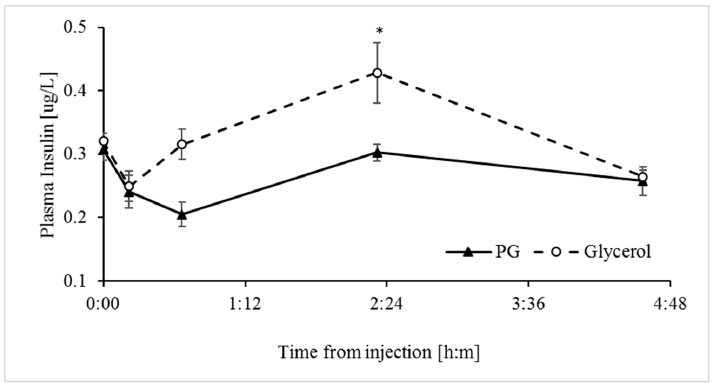
Figure 4. Insulin response to the propylene glycol and glycerol treatments. Analyses indicate the effects of Treatment and Time (Table 1). * Significant difference at α = 0.0125 after Bonferroni correction. SEM = 0.01. Values represent mean ± SE.